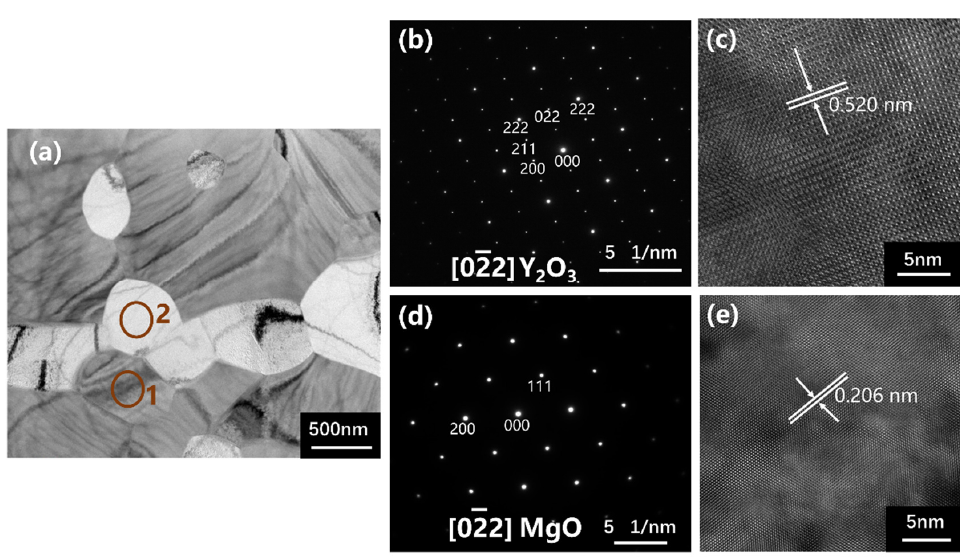
Figure 9. ( a ) The TEM micrograph of fracture surfaces of MgO-Y 2 O 3 ceramic; ( b , c ) the SAED pattern and TEM image corresponding to Area 1 marked in ( a ); ( d , e ) The SAED pattern and TEM image corresponding to Area 2 marked in ( a ).